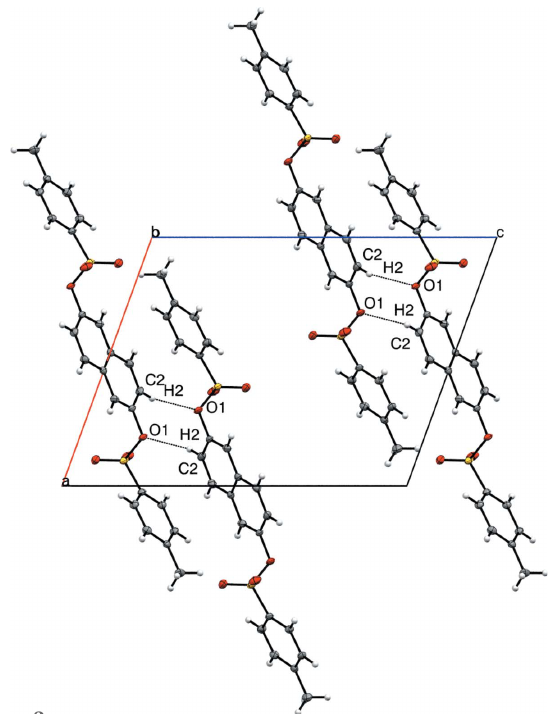
Figure 2 The crystal packing of the title compound, viewed along the b